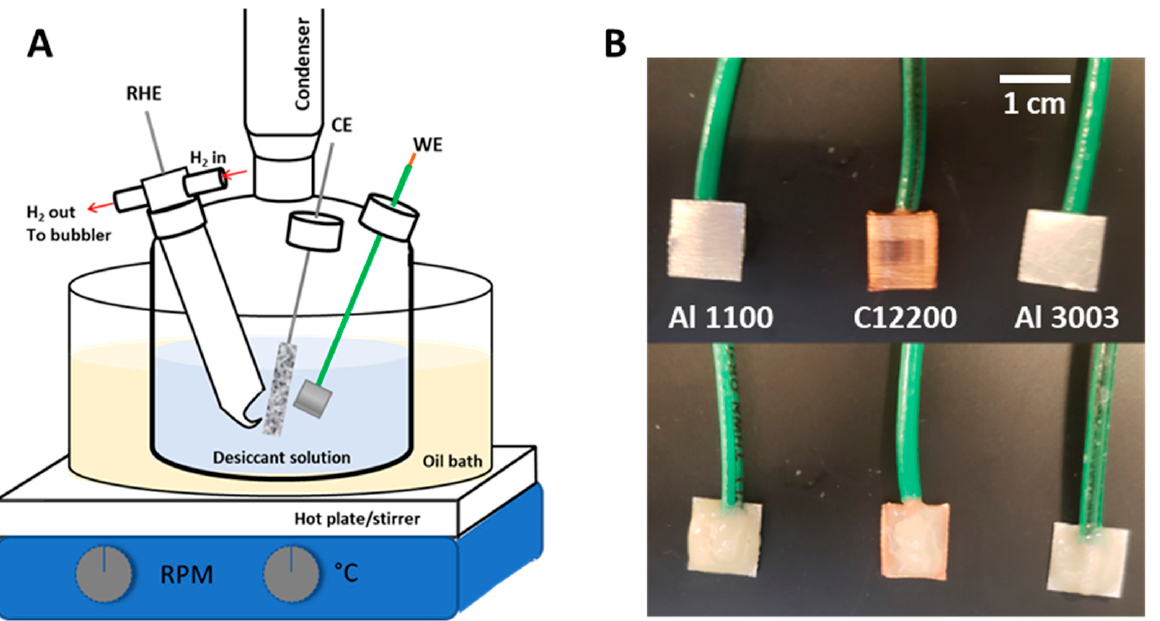
Figure 1. ( A ) Schematic of the electrochemical cell utilized to perform electrochemical corrosion evaluation. This is a three-electrode setup utilizing a reference hydrogen electrode (RHE), a platinum mesh counter electrode (CE), and a working electrode (WE) made of the metal or metal alloy sample. ( B ) Examples of the front ( top ) and back ( bottom ) of the WEs that were fabricated for these experiments.